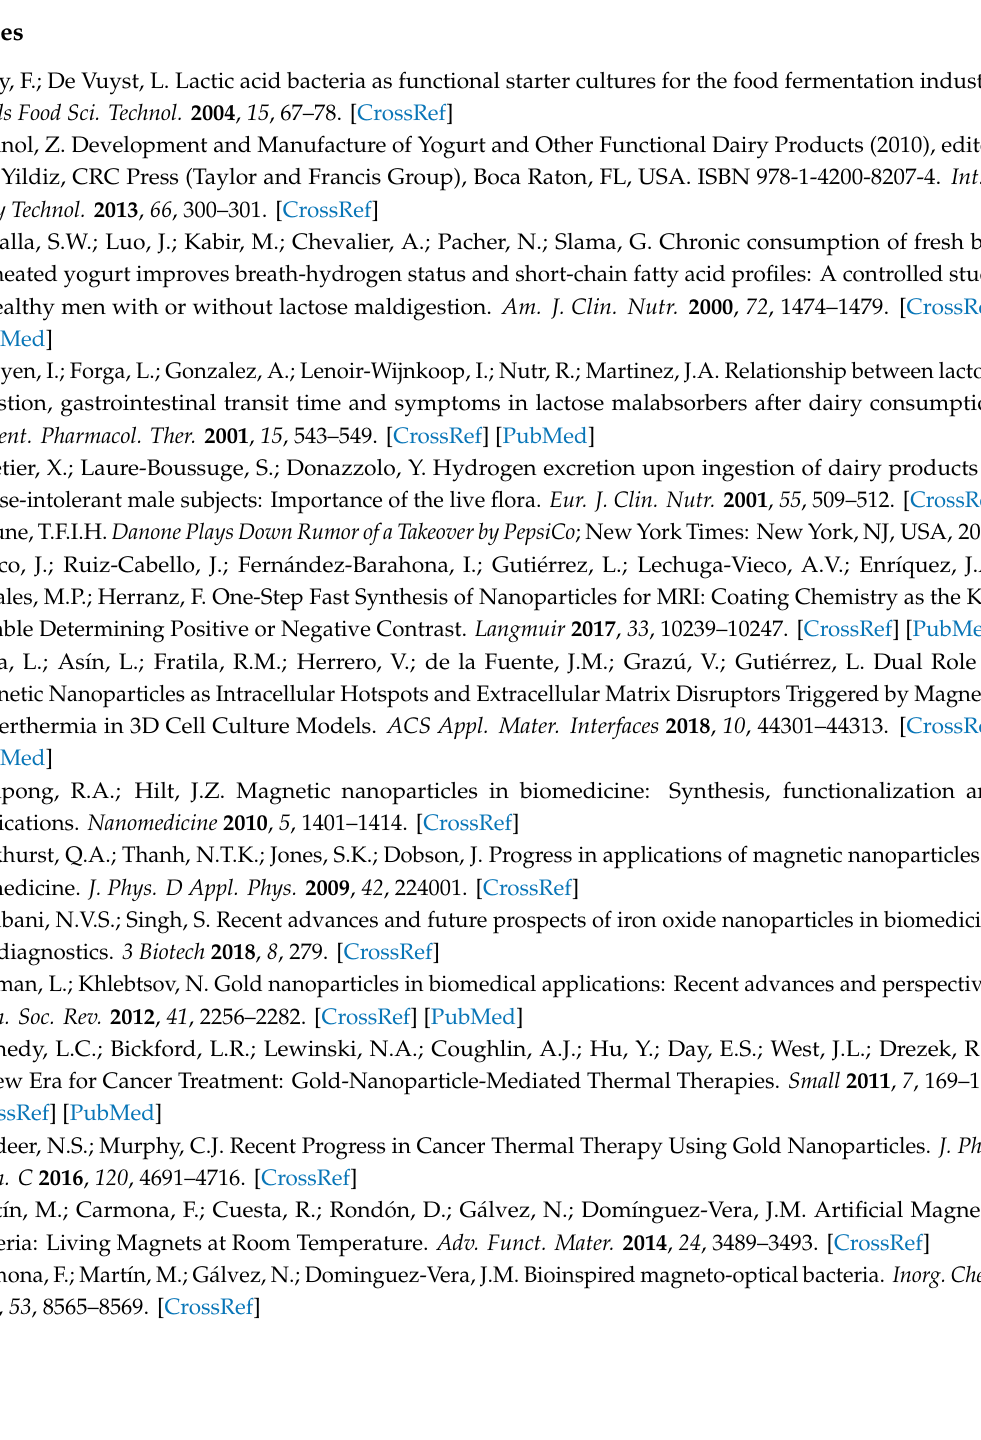
Figure S1: TEM images of AuNPs before adhesion to bacteria and their typical SPR bands; Video S1: Movement of the magnetic liquid yogurt attracted by a 1.2 T